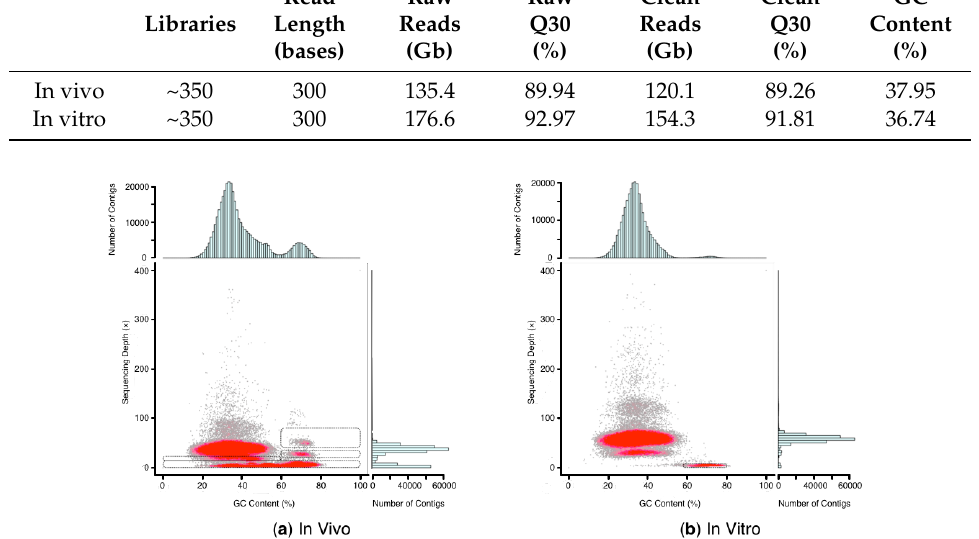
Figure 2. GC content and average sequencing depth distribution of in vivo ( a ) and in vitro ( b ) M. cordata . The x -axis represents the GC content of contigs while the y -axis represents their average depth. Each dot represents an individual contig. The red region indicates high-density portions of the contigs. The extracted regions are indicated by the dashed rectangle. The distribution of contig depth is posited on the right while the distribution of GC content is on the